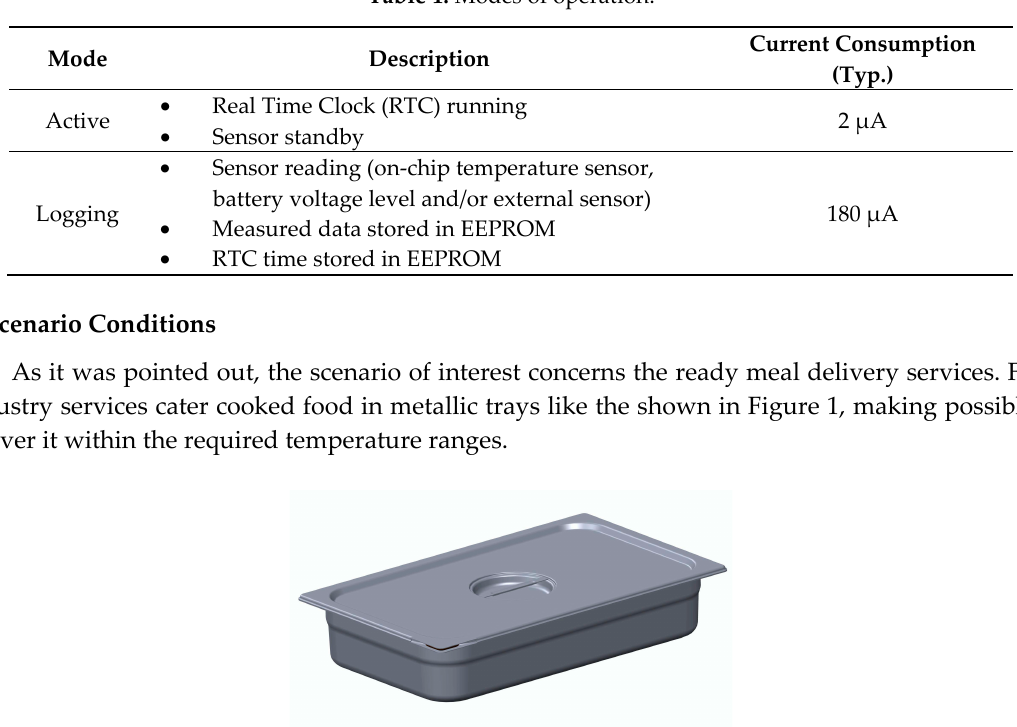
Table 1. Modes of operation.